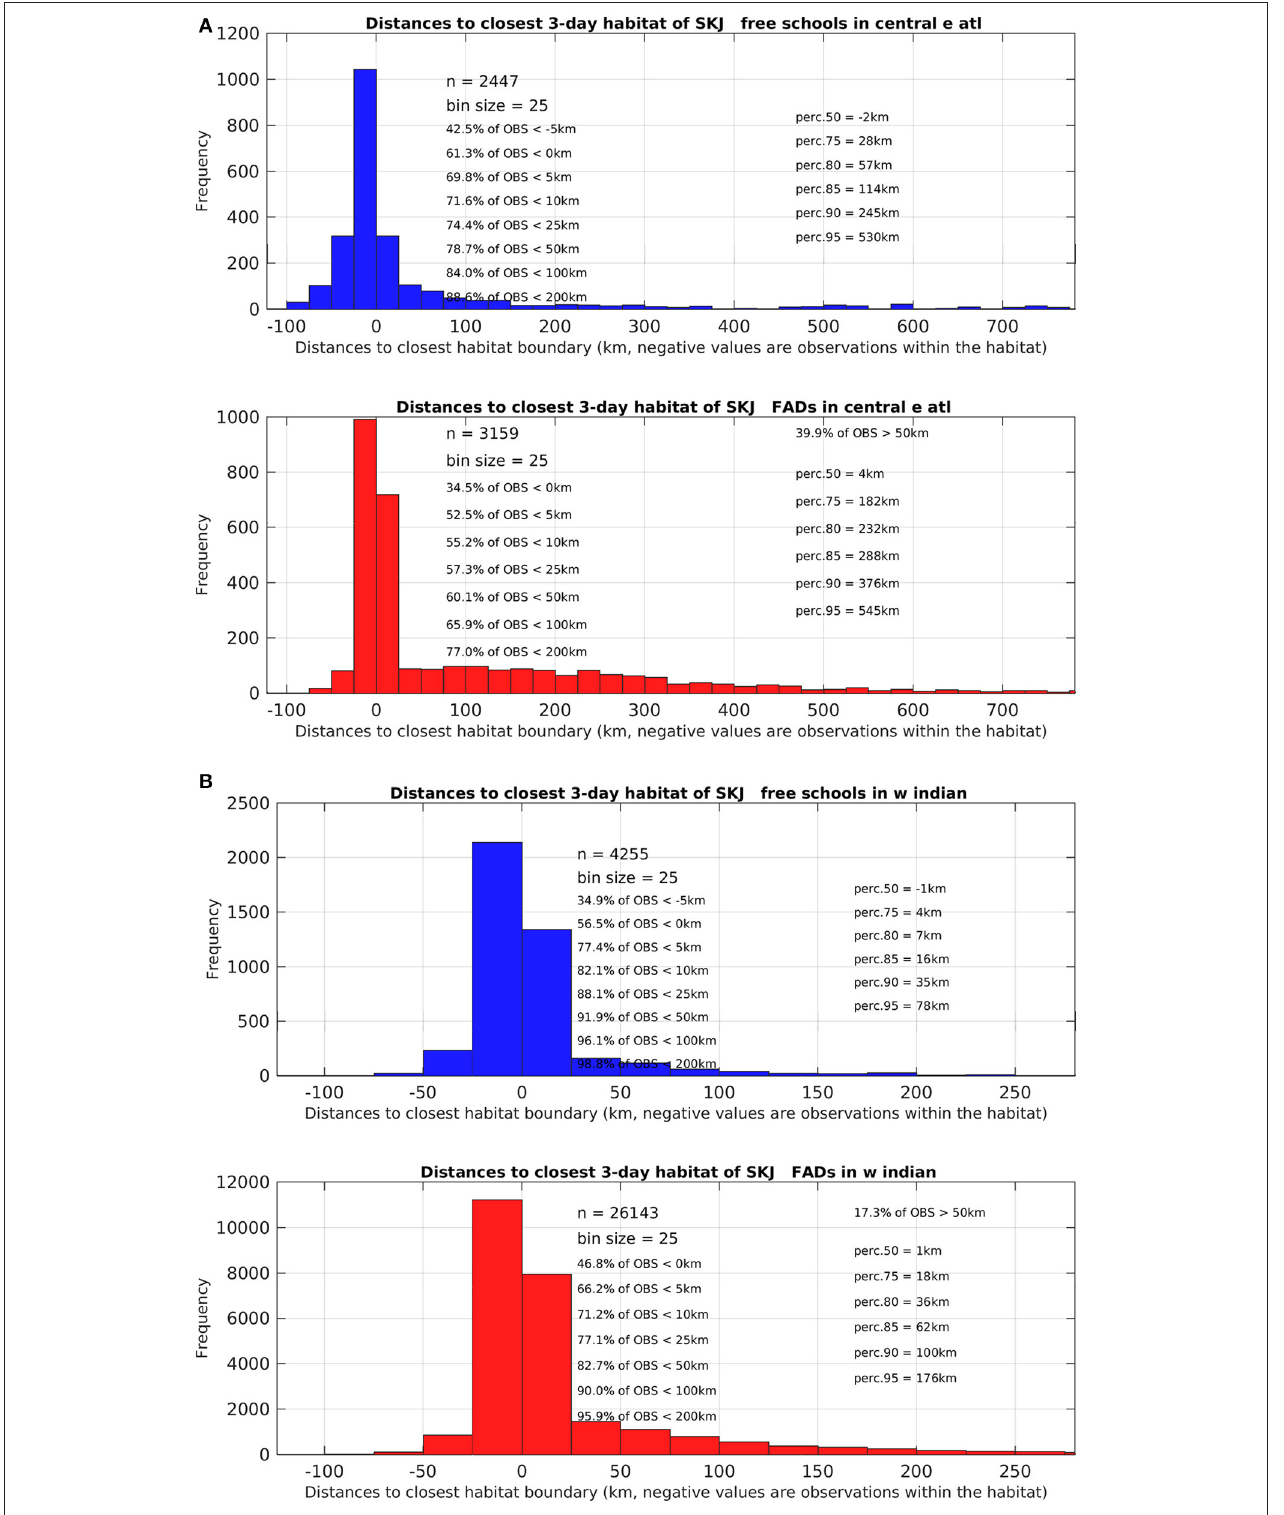
FIGURE 5 | Detailed histograms and statistics of relating to the distances observed between skipjack tuna ( Katsuwonus pelamis ; SKJ) presence data (free-swimming school set (FSC) data shown in the upper blue graph and drifting fish aggregating device associated sets (dFAD) shown in the lower red graph) to the closest favorable feeding habitat boundary in (A) the Eastern Central Atlantic Ocean and (B) the Western Indian Ocean. Negative distance values correspond to presence data points observed within the favorable feeding habitat. Note the different ranges on the x-axis between the two study areas.